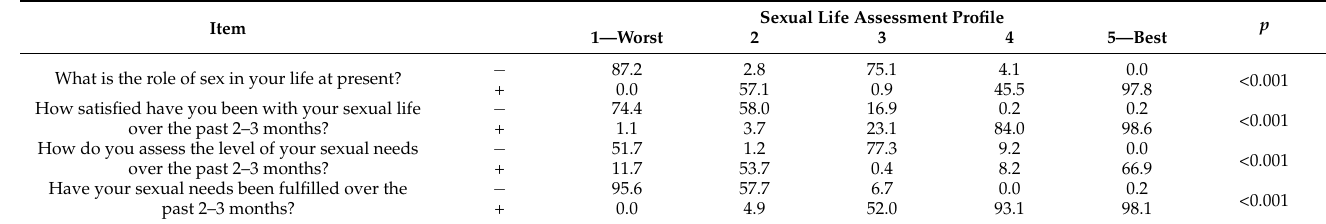
Table 3. Evaluation of sexual life in 2021 according to sexual life profiles (% of positive and nega- tive